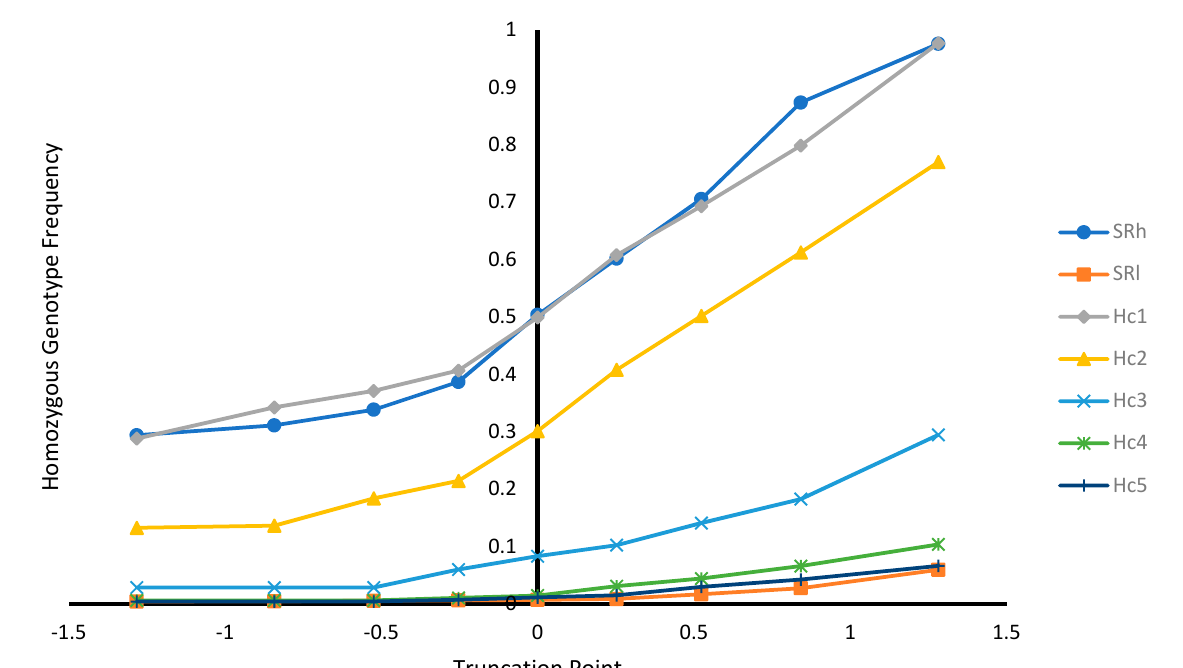
Figure 4. Homozygous genotype frequency at different selection truncation points in unit of standard deviations.